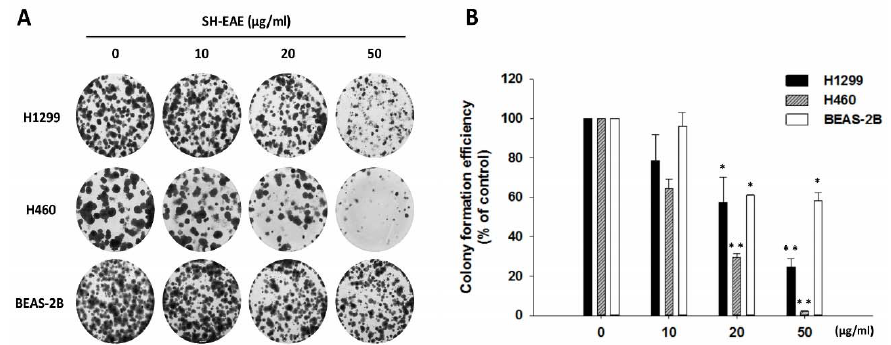
Figure 4. SH-EAE treatment inhibited colony-forming ability in malignant NSCLC cells but not in normal human bronchial epithelial cells. ( A ) Colony formation assay in 6-well plates. Two NSCLC cell lines, H1299 and H460, and non-tumorigenic bronchial epithelial BEAS-2B cells were treated with different concentrations of SH-EAE (10, 20, and 50 µ g/mL) for 14 days. Afterward, the cells were fixed in 4% paraformaldehyde and stained with Giemsa. ( B ) The quantification analysis of the colony area. Cells were treated as described above, bright-field images were obtained independently with the same objective lens and the areas covered by the cell colonies were measured using ImageJ software. Data represent the mean ± SD of three independent experiments (* p < 0.05; ** p < 0.001).